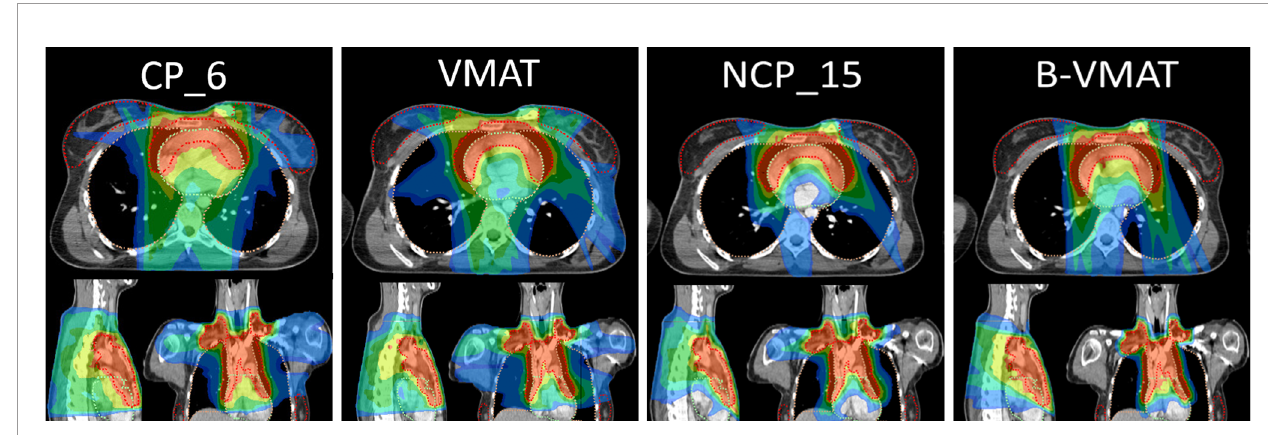
FIGURE 3 | Dose distributions for patient 3. CP_6 was added as, on average, six beams were used clinically. CP_15 was similar to VMAT and was therefore not added. The isodose lines are percentages relative to the prescribe dose, i.e., 100% = 30 Gy, with color legend as light blue, 16.7% (5 Gy as OAR constraints); azure, 20%; light green, 40%; dark green, 60%; yellow, 80%; red,